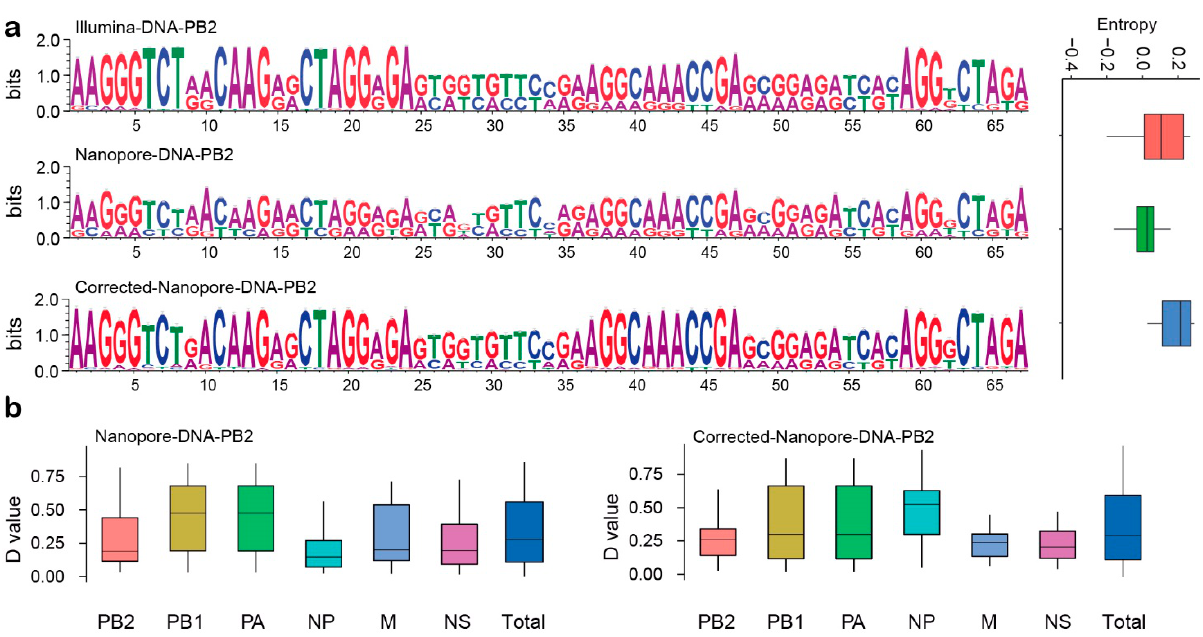
Figure 7. Demonstration of the effects before and after the modification of the clonotype sequences. ( a ) Sequence logo of variation sites and its entropy distribution in three sequencing results. ( b ) The distribution of the D value obtained by comparing the clonotype sequence of each fragment before and after modification with the clonotype sequence obtained by the Illumina platform.